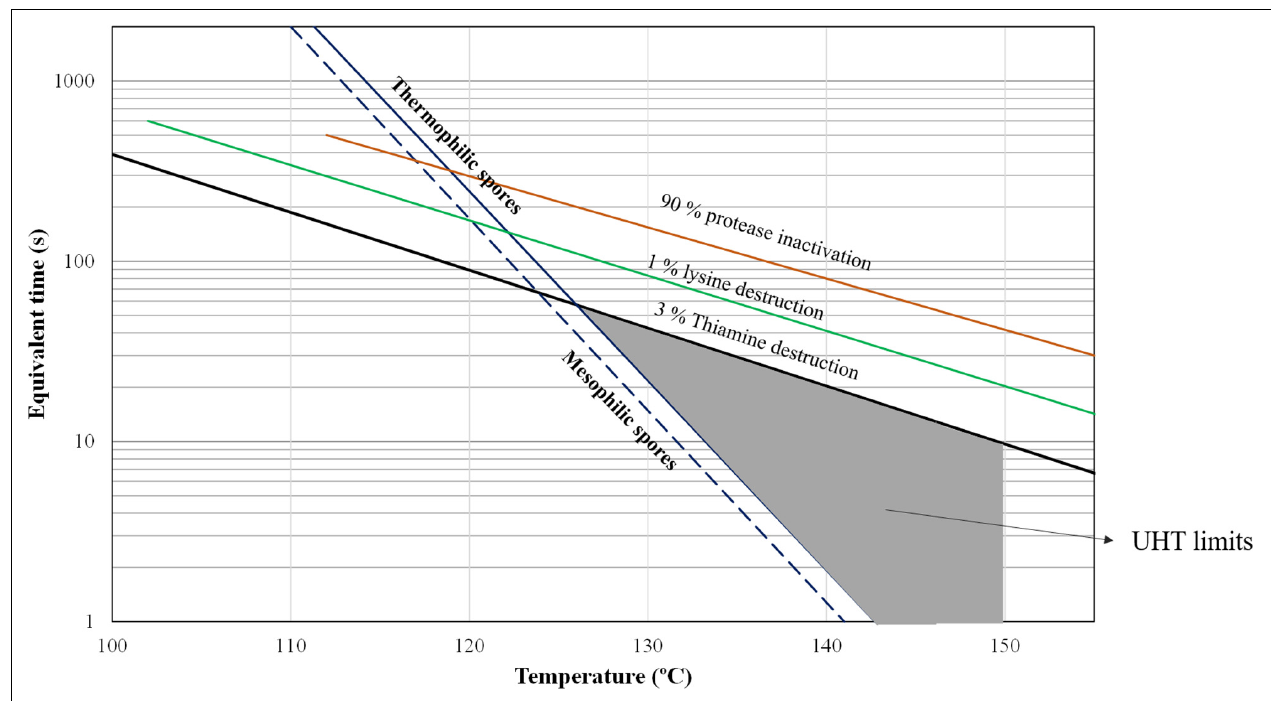
FIGURE 2 | Effect of temperature and equivalent time on the lethality of common spores in raw milk, indicating the UHT conditions to produce safe long-life milk [adapted from Bylund et al. (2)].